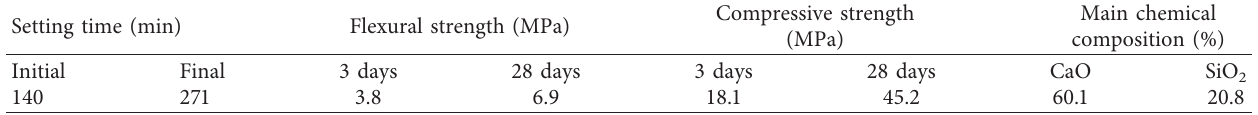
Table 1: Properties of ordinary Portland cement.